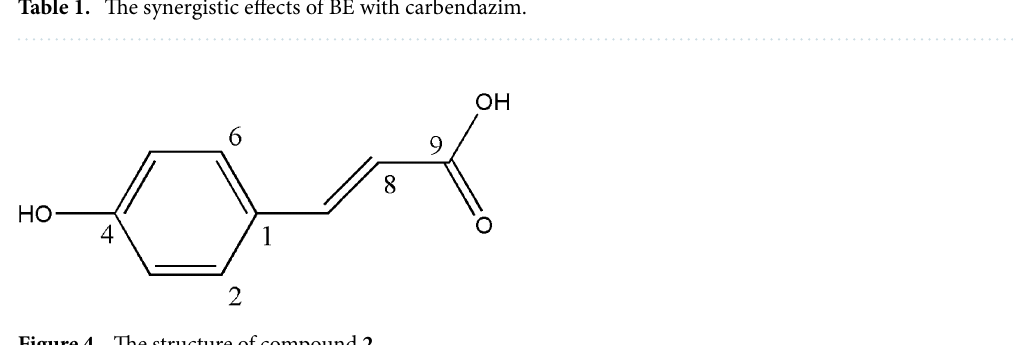
Table 1. The synergistic effects of BE with carbendazim.